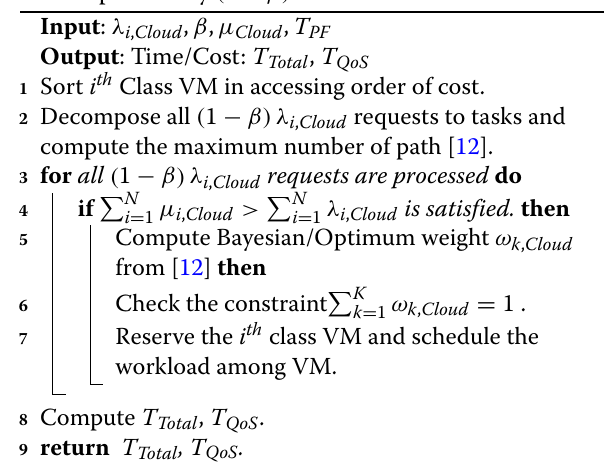
Algorithm 2: Workload scheduling at cloud